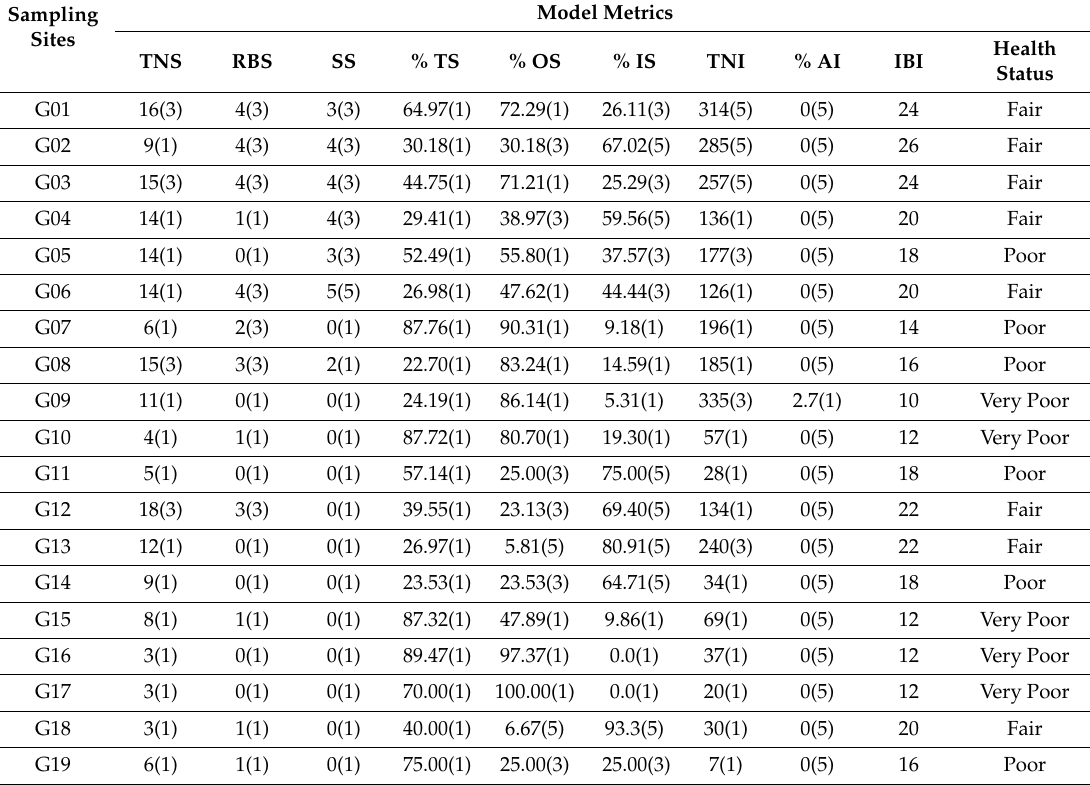
Table 3. Biological health assessment using index of biotic integrity model (TNS: total number of native species, RBS: total number of ri ffl e benthic species, SS: total number of sensitive species, % TS: % individuals as tolerant species, % OS: % individual as omnivores, % IS: % individuals as native insectivores, TNI: total number of individual, % AI: % individuals with